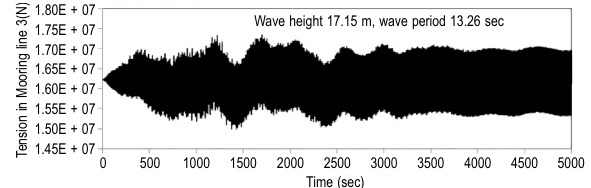
Fig. 7. Spar rotational motion response in pitch direction